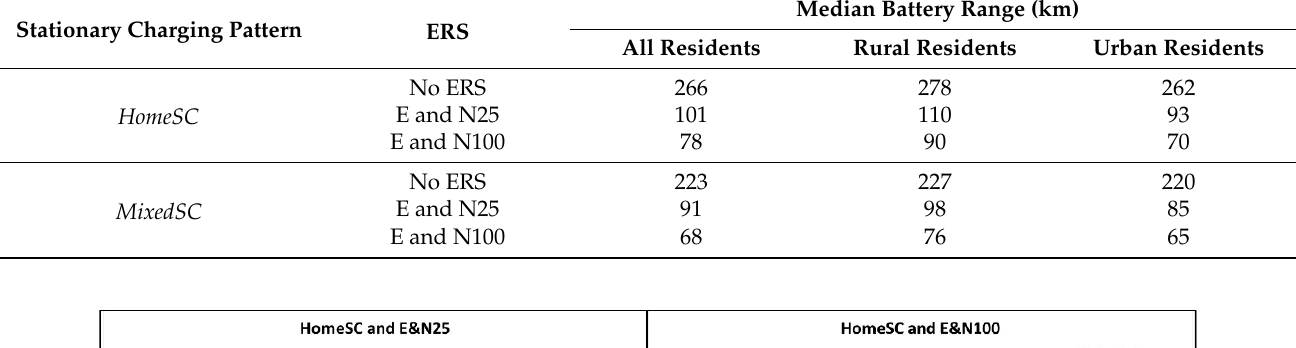
Table 1. The median of battery ranges for rural and urban drivers without/with ERS (2 e ). E and N25: ERS on 25% of E and N roads, E and N100: ERS on 100% of E and N roads. HomeSC: home-only stationary charging, MixedSC: home and other stationary charging.